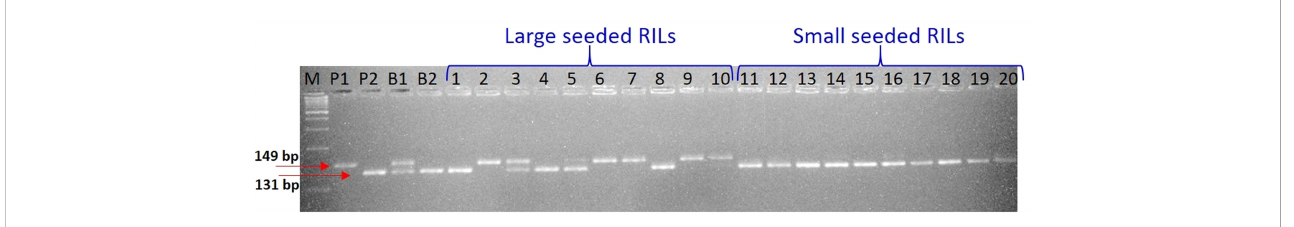
FIGURE 5 Gel picture showing individual plant analysis (constituting the bulks) for seed size with PBALC449 marker. Where, P1: L4602, P2: L830, B1: Large seeded bulk, B2: Small seeded bulk, 1-10: Individual plants constituting the large-seeded bulk; 11-20: Individual plants constituting the small seeded bulk, M: DNA